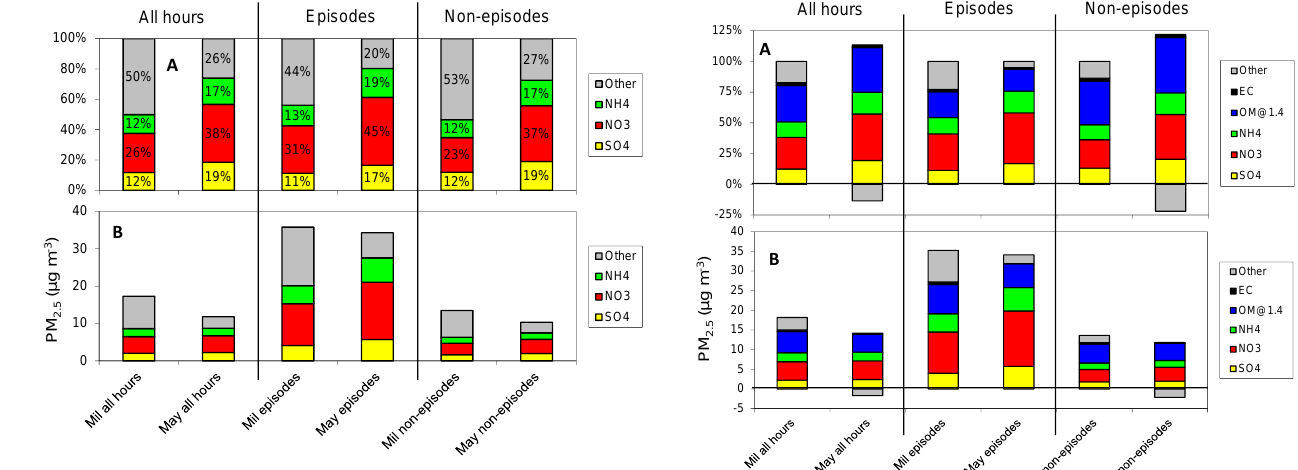
Figure 6. Inorganic composition on a fractional (A) and absolute (B) basis. 977 Fig. 6. Inorganic composition on a fractional (A) and absolute (B) basis.